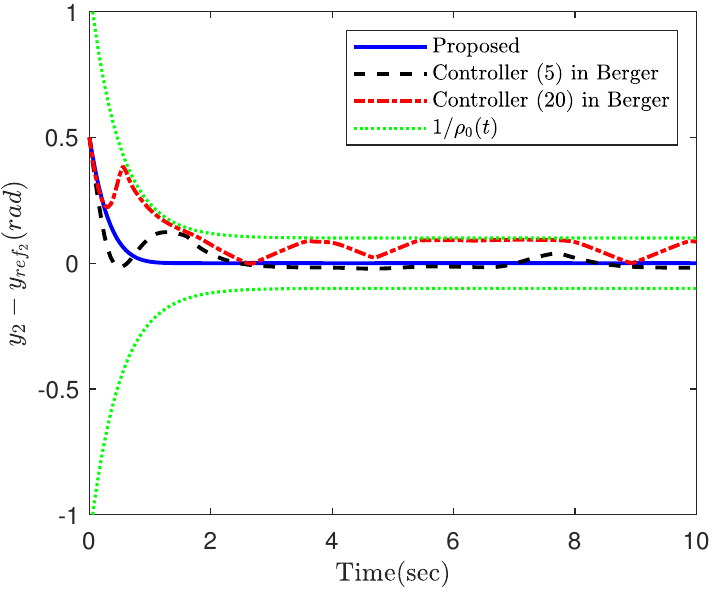
Figure 8. The tracking error of the second joint in Part